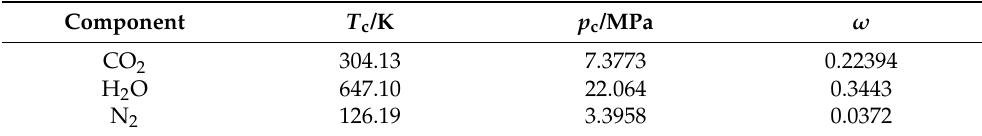
Table 10. Critical temperature, T c , critical pressure, p c , and acentric factor, ω , for CO 2 , H 2 O and N 2 used in the PR-EOS